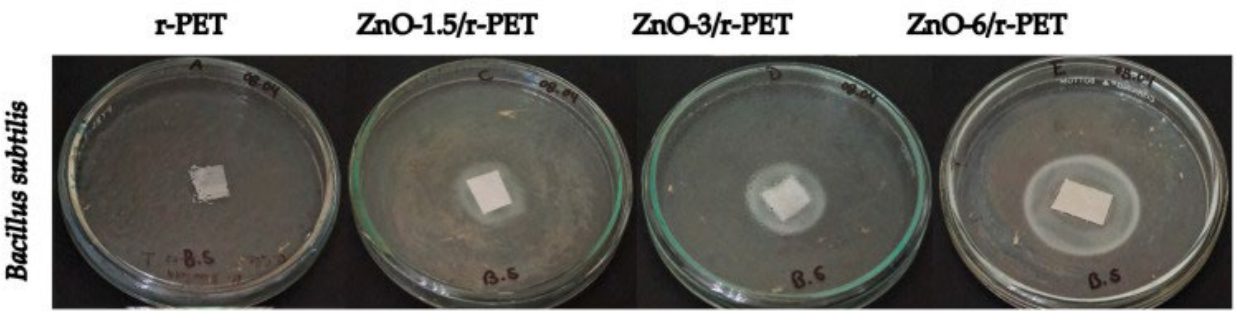
Figure 10. Antibacterial tests Bacillus subtilis in polymer composite fibers [107] .